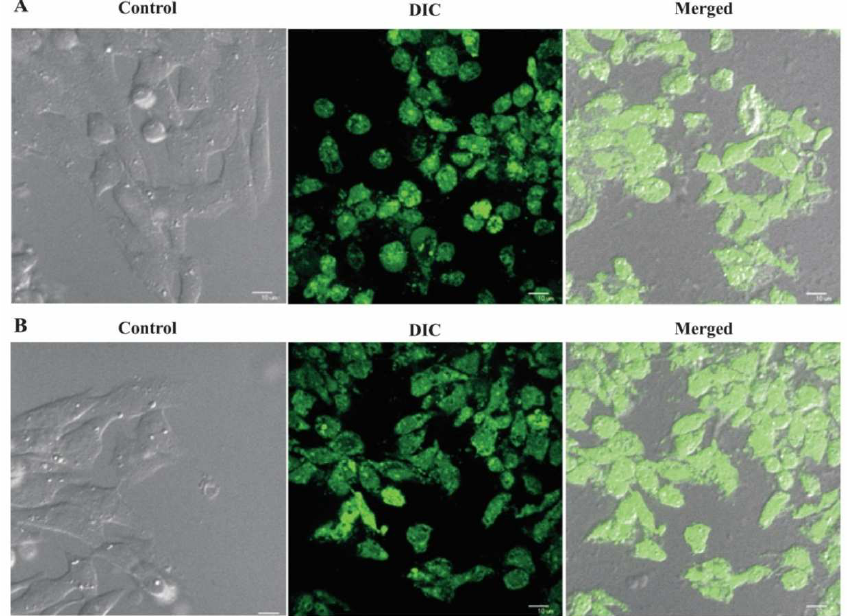
Figure 8. In vitro cellular uptake of antibody conjugated nanolipid vesicles in MCF-7 breast cancer cells. ( A ) Formulation at concentration 50 μg/mL for 1 h; ( B ) formulation at concentration 100 μg/mL for 2 h.